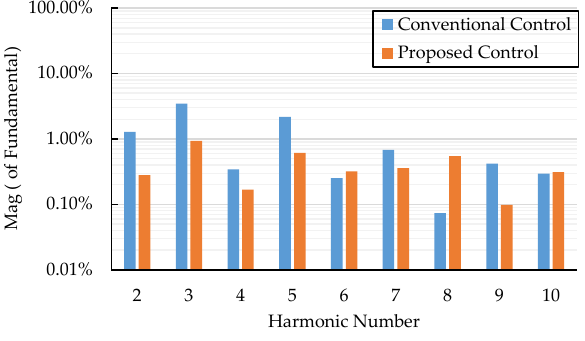
Figure 13. The magnitudes of the 2nd–10th harmonic voltages respect to the fundamental voltage.